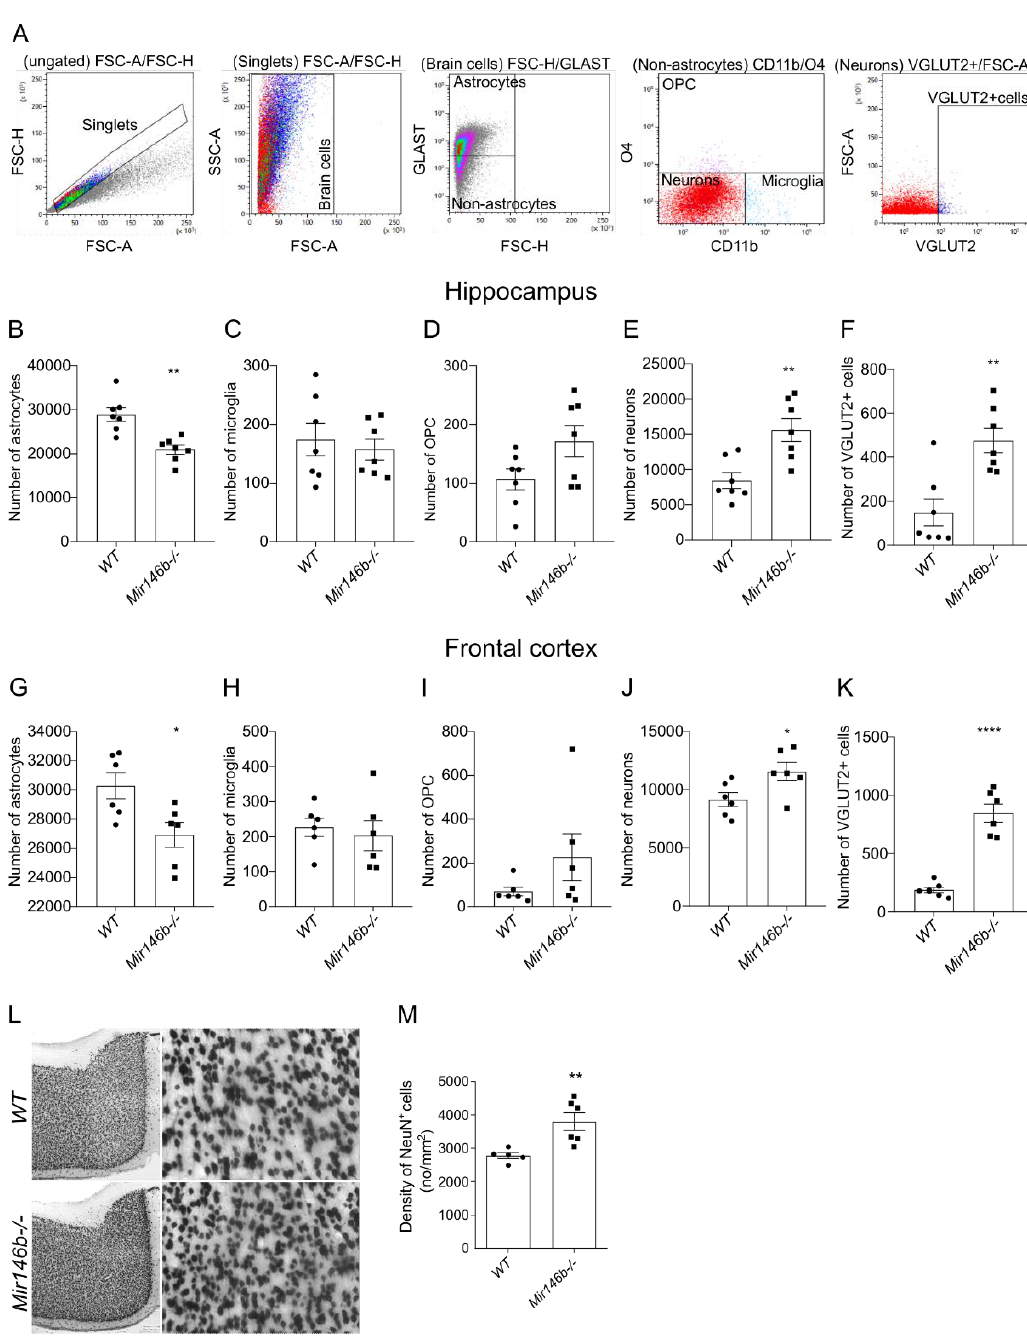
Figure 4. miR-146b deficiency causes altered brain cell abundancy in the hippocampus and frontal cortex of the mouse brain determined by flow cytometry and immunohistochemistry. ( A ) Repre- sentative graphs showing flow cytometry gating strategy for astrocytes, microglia, oligodendrocyte precursor cells (OPC) and neurons. ( B ) Number of astrocytes among total brain cells. ( C ) Number of microglia, ( D ) OPC and ( E ) neurons among non-astrocytes. ( F ) Number of VGLUT2+ neurons in the hippocampus and ( G – K ) frontal cortex of WT and Mir146b -/- mice. ( L ) Representative immunohisto- chemistry microphotographs of the frontal cortex NeuN+ sections at 40 × and 200 × magnification and ( M ) quantification of NeuN-positive neuronal density in the frontal cortex of WT and Mir146b-/- mice. Number of animals = 5–7, Student’s t -test. Data represented as mean ± SEM; * p < 0.05, ** p < 0.01, **** p < 0.0001.